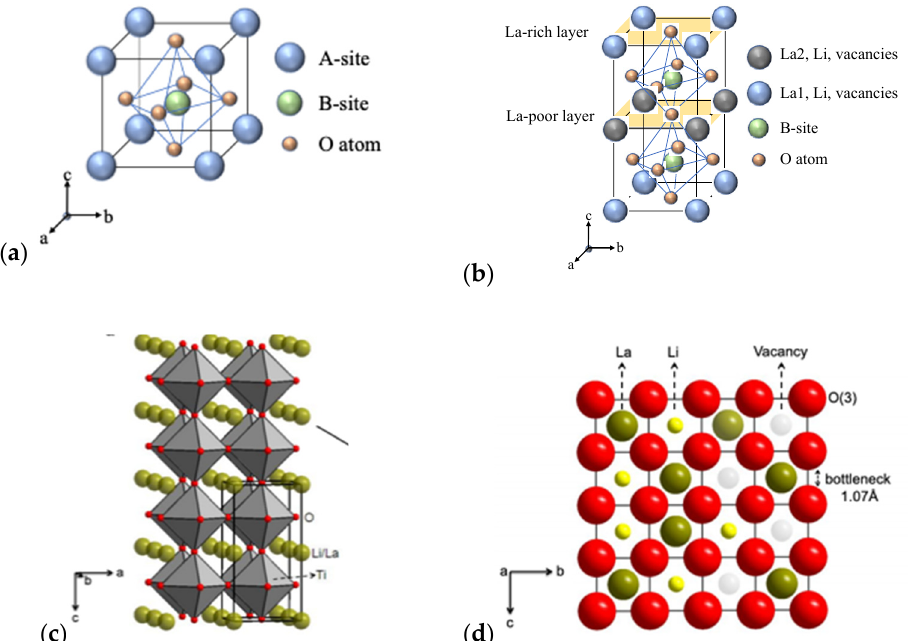
Figure 4. ( a ) ABO 3 structure; ( b ) La-rich and La-poor regions; ( c ) Crystal structure of ( P4/mmm )-type LLTO [60]; and ( d ) bottleneck structure of 12-fold coordinated with oxygen ions [60].